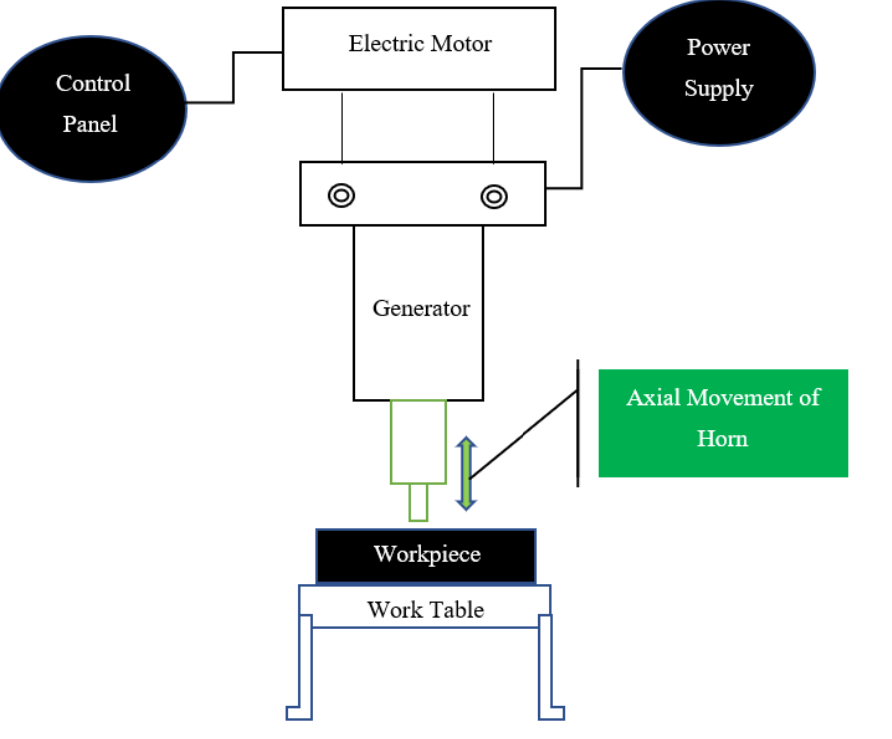
Figure 1. The basic setup of USM and its